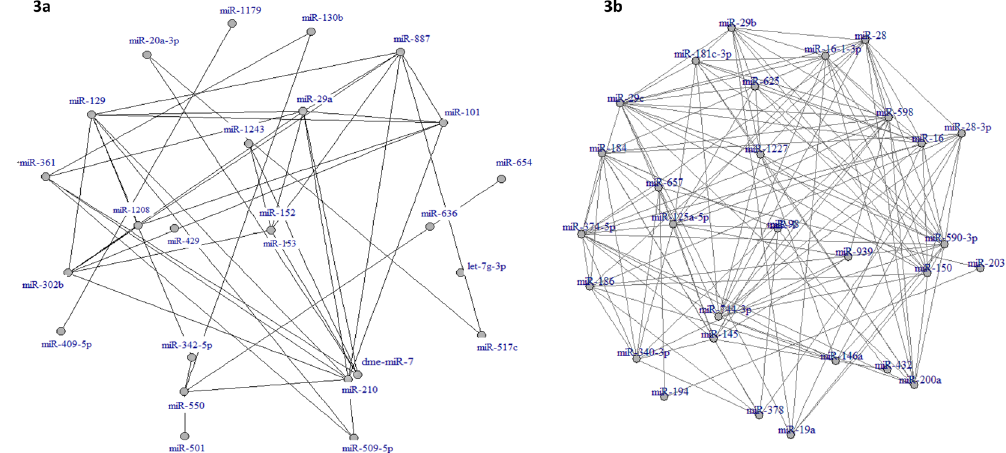
Figure 3. miRNA co-expression network analysis. ( a ) A core set of 25 miRNAs were selectively and highly co- expressed within the suicide group but not in the healthy group. ( b ) A core set of 30 microRNAs were strongly co-expressed and interconnected in the healthy control, but not in the suicide